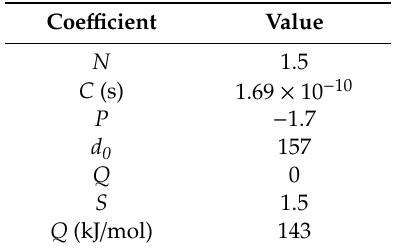
Table 3. Coe ffi cients for SRX process from [26].